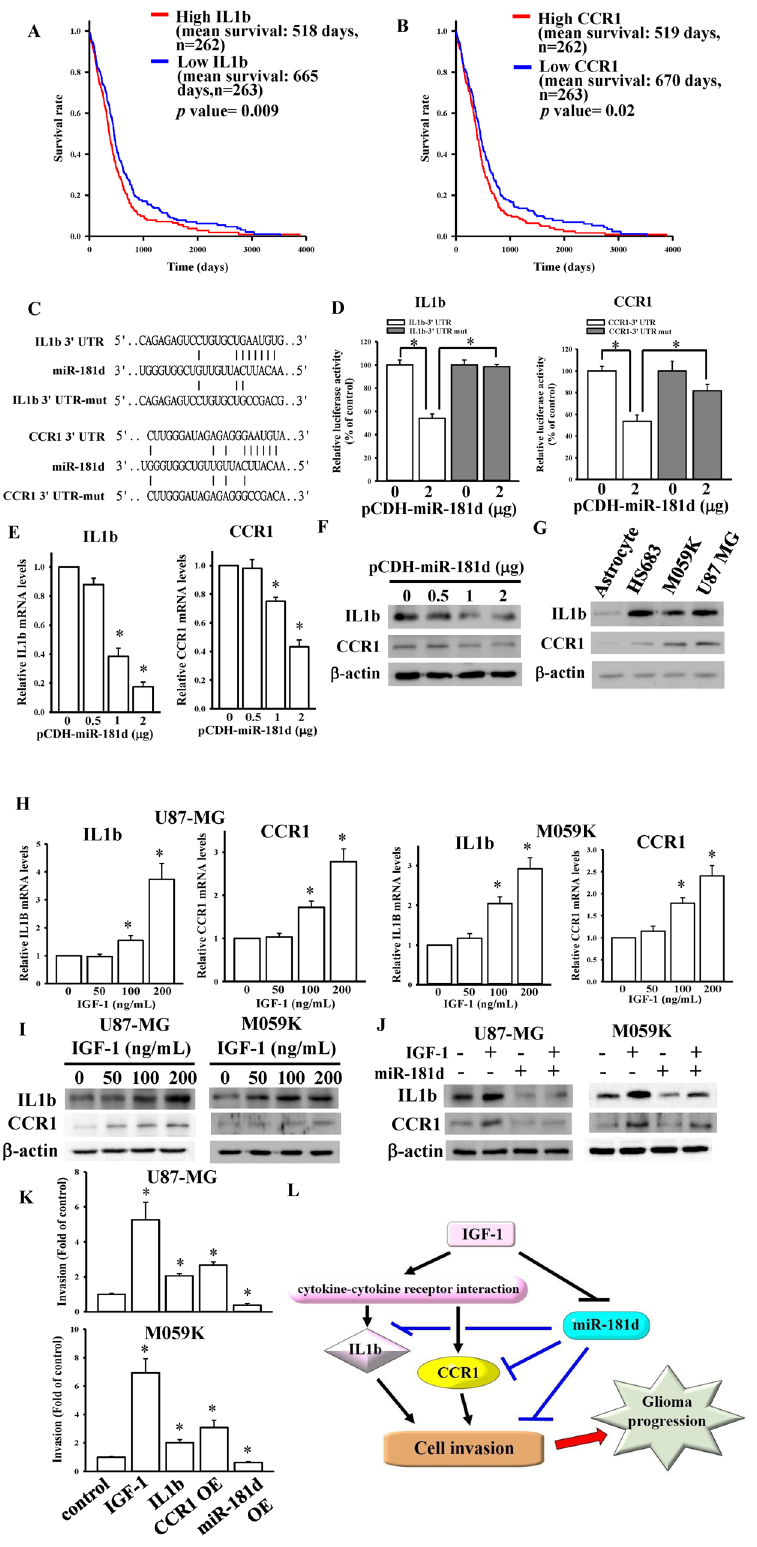
Figure 5. Interleukin (IL)-1b and C-C chemokine receptor type 1 (CCR1) were identified as direct target genes of miR-181d. Kaplan-Meier survival curves were analyzed in the IL-1b ( A ) and CCR1 ( B ) groups. The survival rate was calculated by multivariate permutation tests (with a false discovery rate (FDR) of < 0.01). TCGA GBM patients were divided into two groups based on the median expression cutoff points of IL-1b and CCR1 levels. ( C ) Schematic diagram of potential miR-181d-targeted sites in the 3 ′ -untranslated region (UTR) of the IL-1b and CCR1 genes. ( D ) Effects of miR-181d on 3 ′ UTR luciferase activity of the IL-1b and CCR1 genes. To